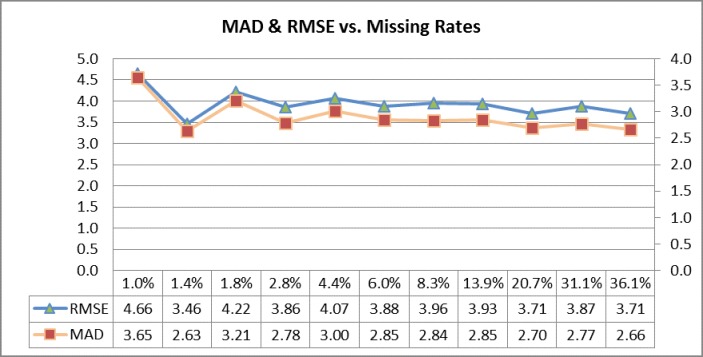
Initial variogram.